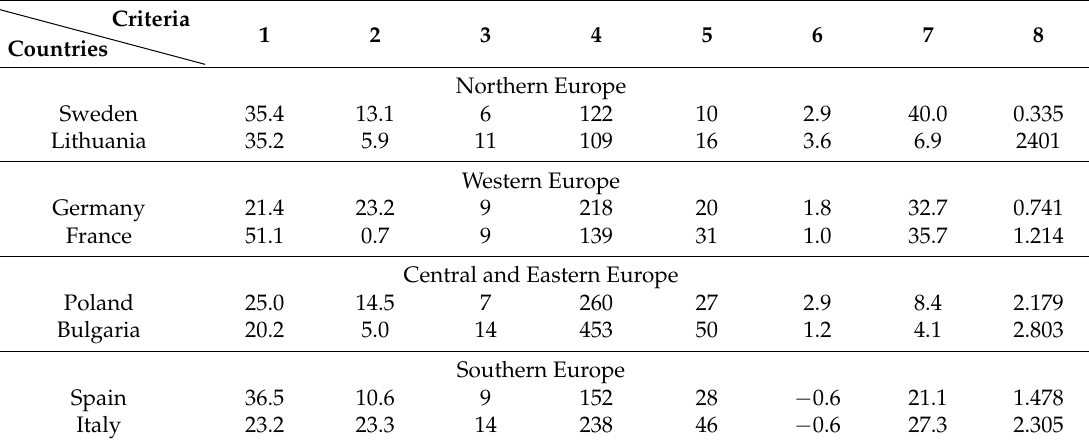
Table 3. Values of criteria of the tax competitiveness.